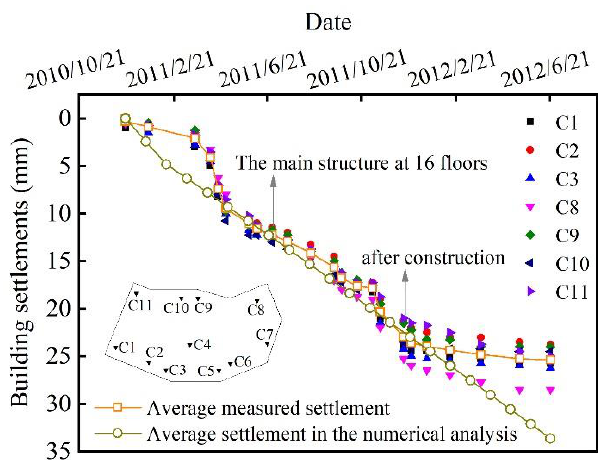
Figure 17. Curve of building settlements variation with time .